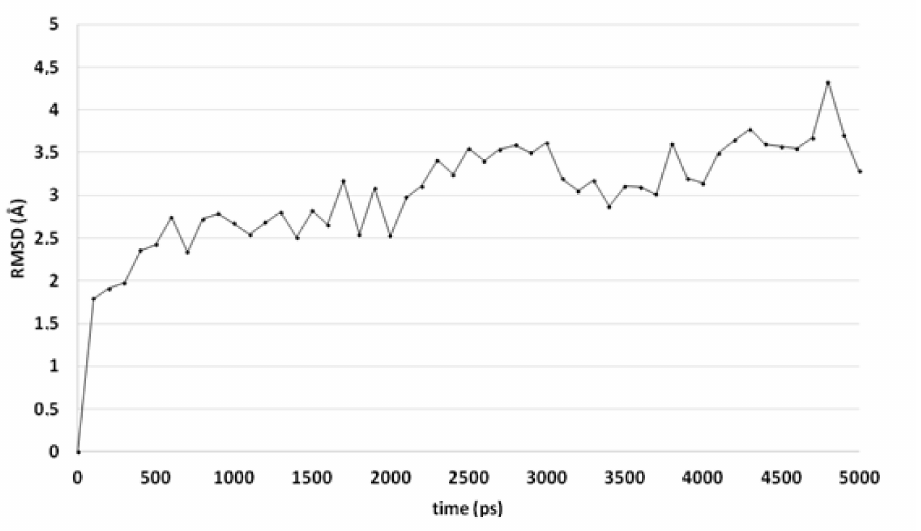
Figure 7. The RMSD of the ligand heavy atoms during the 5-ns molecular dynamics simulation of compound 4o in the active site of